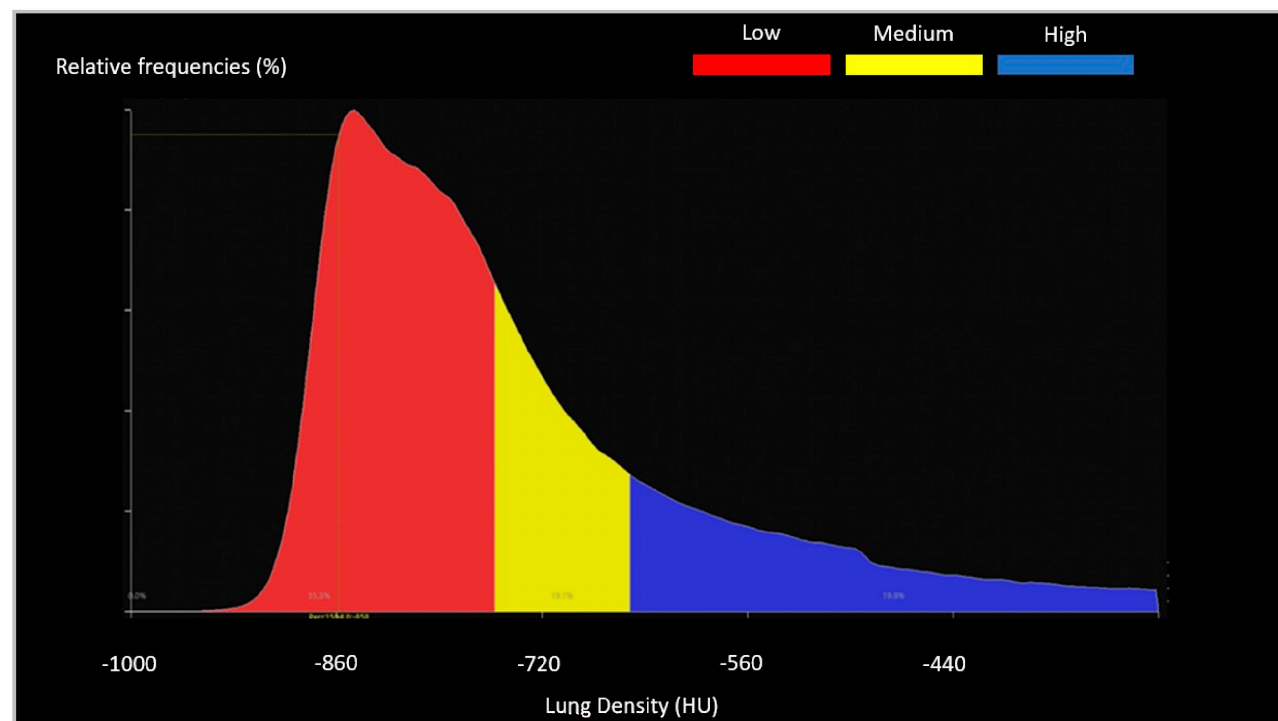
Figure 4. CT Lung Density Analysis. This image shows: ( a ) parenchyma contouring; ( b ) lesion display; ( c ) manual editing; ( d ) final result with a volumetric rendering